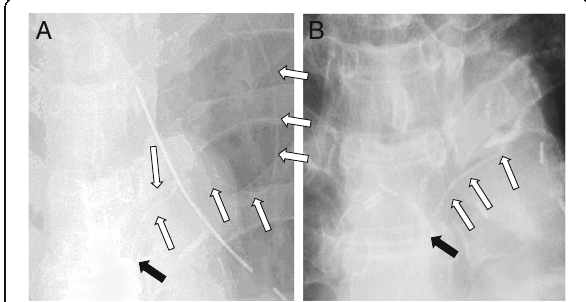
Fig. 1 Chest radiographs showing the position of the catheter after insertion and the retained catheter fragment. The left image ( a ) shows the paravertebral catheter after the insertion procedure ( white arrows ). The right image ( b ) shows the catheter fragment ( white arrows ) remaining after catheter removal. In both images, the black arrow indicates the tip of the catheter